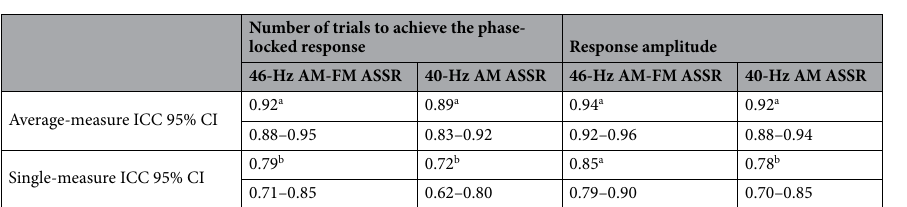
Table 3. Test–retest reliabilities by intraclass correlation coefficient (ICC) among thrice measurements of ASSRs. a Almost perfect. b Substantial.